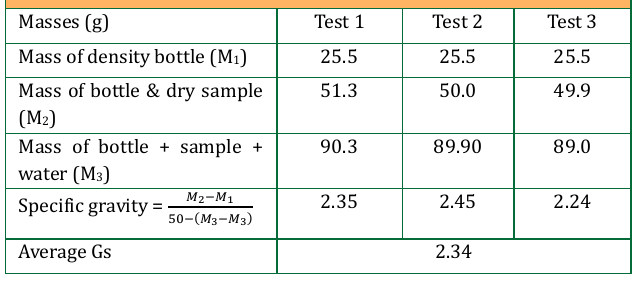
Table 3(c): Specific Gravity Test Result for sample point 3 Masses (g)